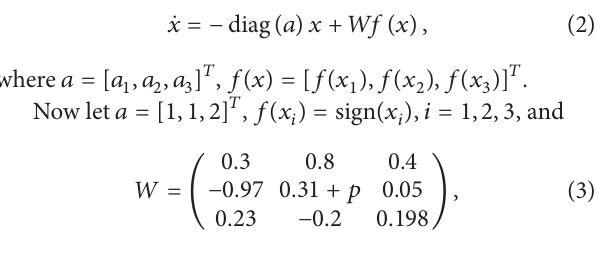
Figure 1: The bifurcation plot of (2) on the crossplane 𝑥 2 = 0 .